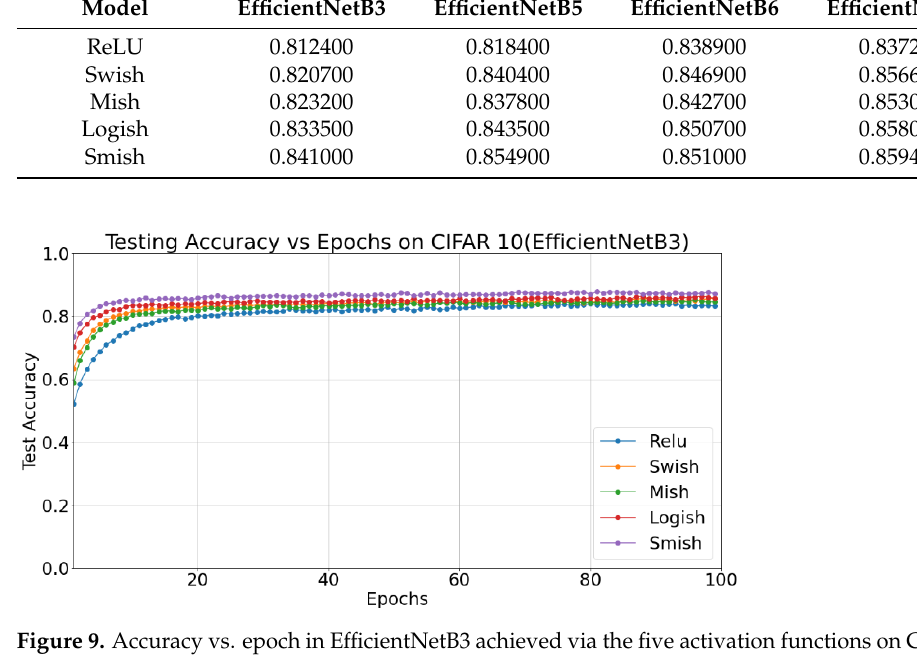
Table 2. Accuracy of EfficientNet models achieved via the five activation functions on CIFAR10. Model